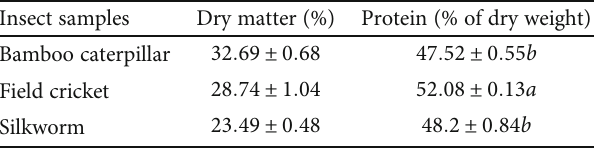
Table 2: Dry matter and protein content in selected insects. Insect